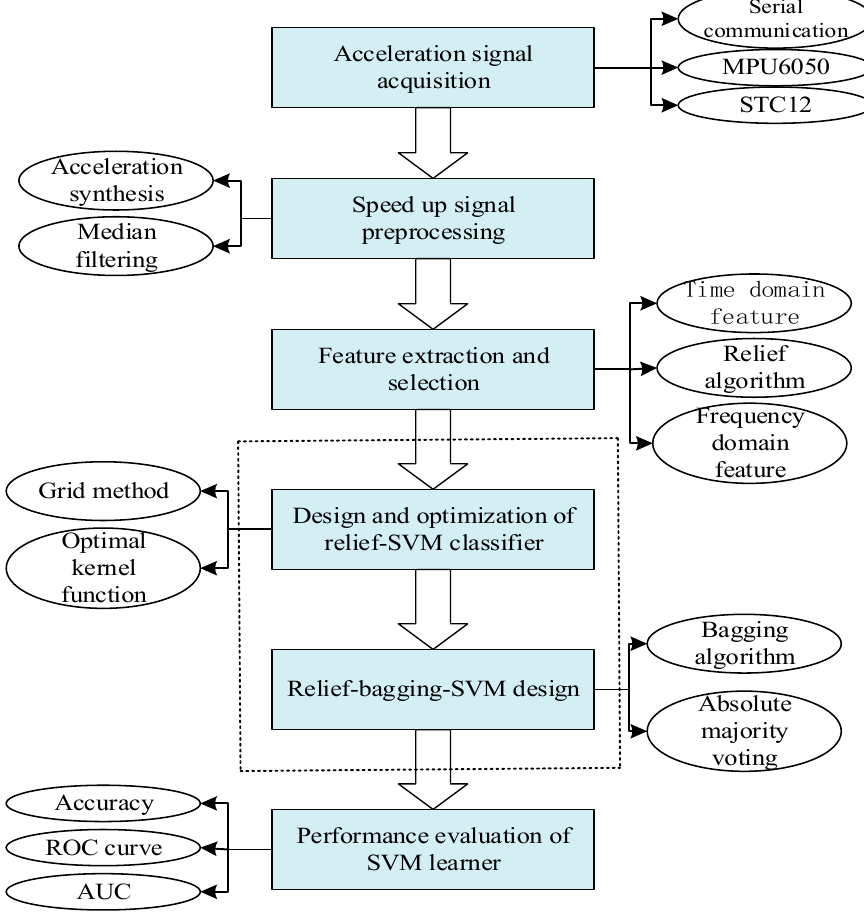
Figure 1. Framework of this article. Receiver Operating characteristic (ROC) Curve.